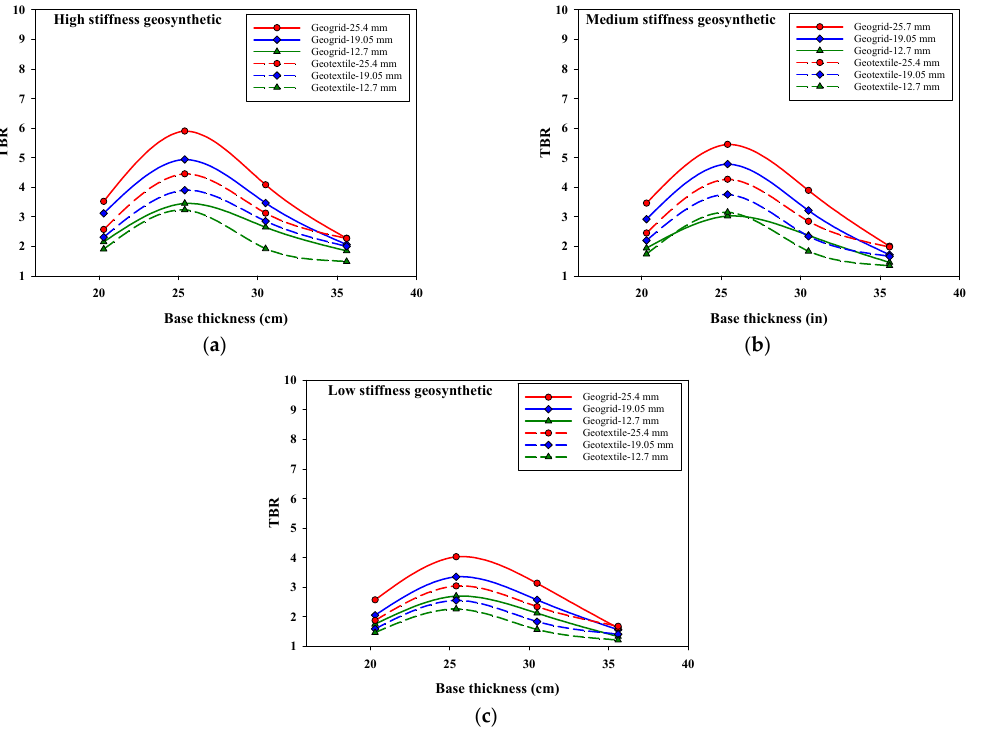
Figure 10. TBR variations with base thickness for pavements reinforced with a single layer of ( a ) high, ( b ) medium, and ( c ) low stiffness geosynthetics on the medium stiff subgrade.